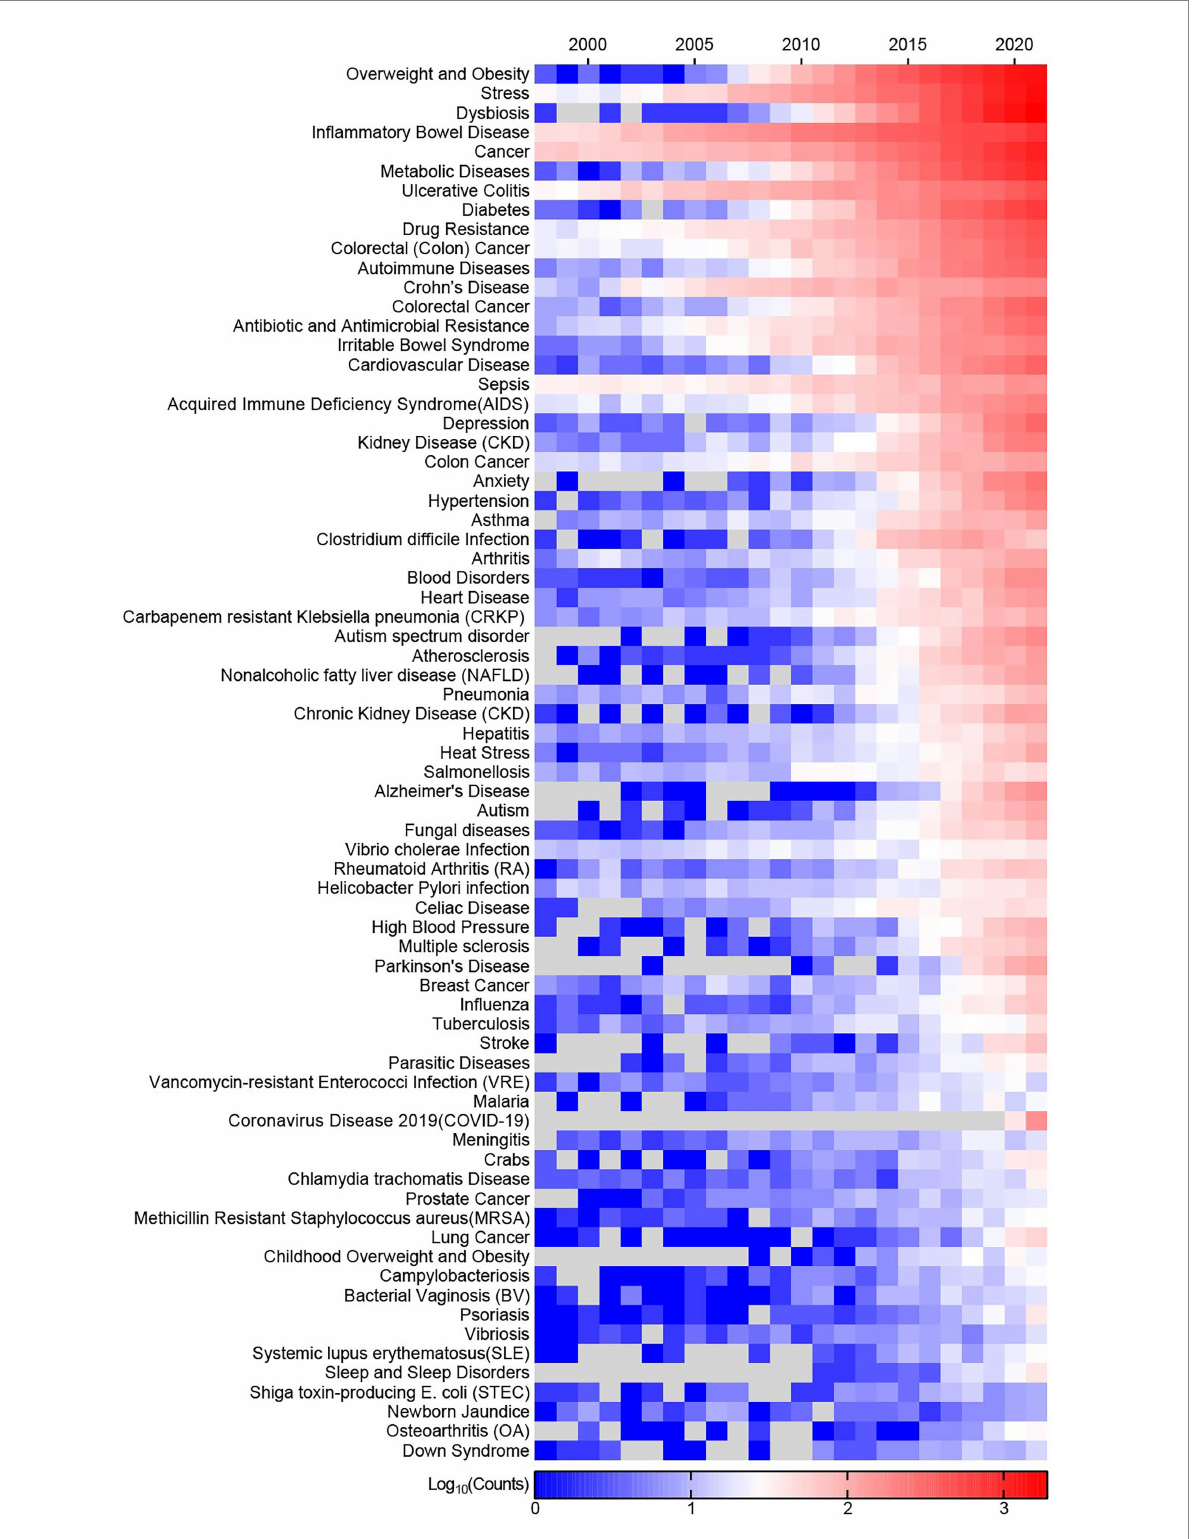
FIGURE 7 Publication trend of diseases and conditions related to gut microbiome from 1998 to